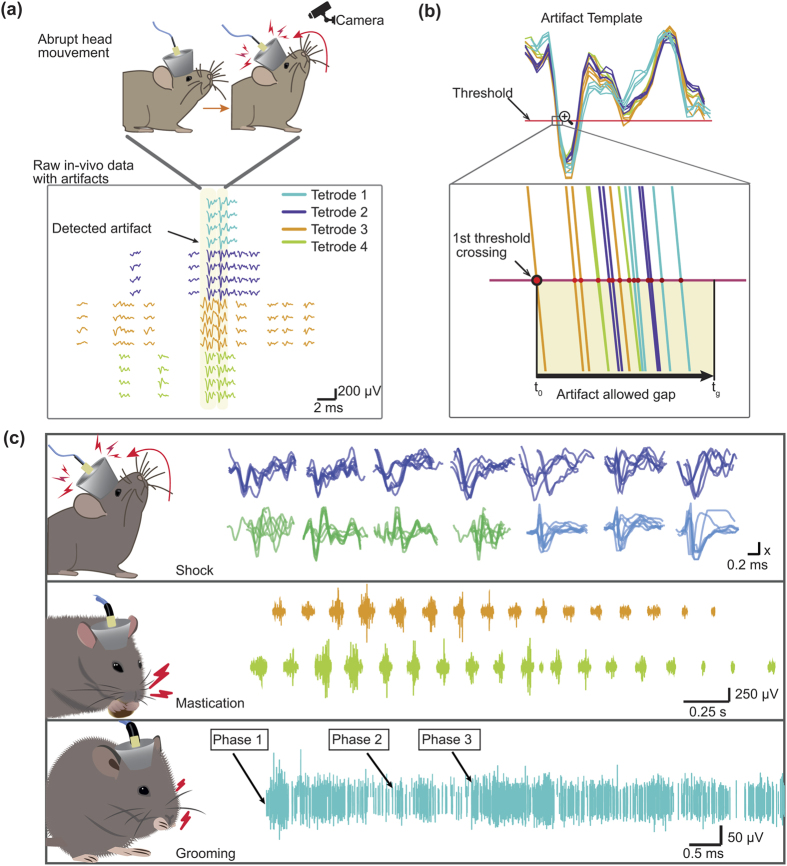
Artefact Library extracted from in-vivo real recordings.Artefact extraction is based on multiple validation criteria. (a) The artefact events were identified during unusual physical events captured by video monitoring (e.g. mechanical shock to the headstage, abrupt movement of the animal, grooming events, etc). (b) The artefacts were identified by their time-coincidence across channels (>80% of the total number of spatially distinct channels) within a width gap parameter (300 μs) starting from the first threshold crossing. (c) The library includes spike-like noise artefacts produced mainly by electronic interference or abrupt head movement, chewing artefacts and grooming artefacts. For the head collision artefacts each set shown in the figure is a superposition of waveforms corresponding to the first channel for each of the 7 tetrodes. The x value of the vertical axis of the scale bar is 20 μV, 30 μV and 40 μV for the blue, green and purple waveforms respectively. Mastication artefacts follow well identified rhythmic patterns (shown in Supplementary Fig. S2). Grooming artefacts appear across channels as high level movement artefacts with variable duration (See Supplementary Table 4).